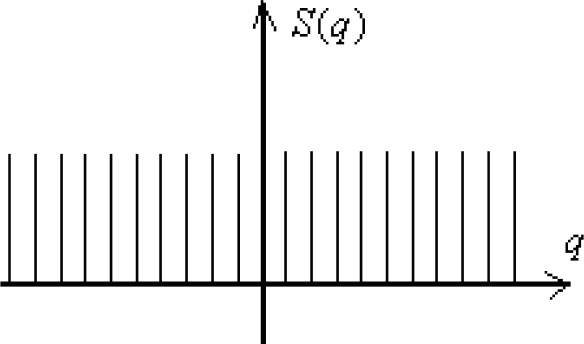
The representation of the “comb” function.